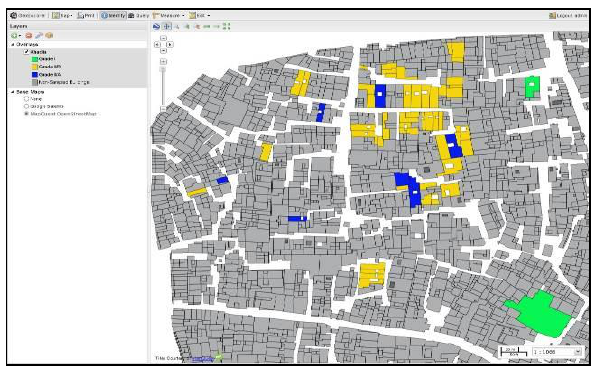
Figure 9. Query generation for a limited